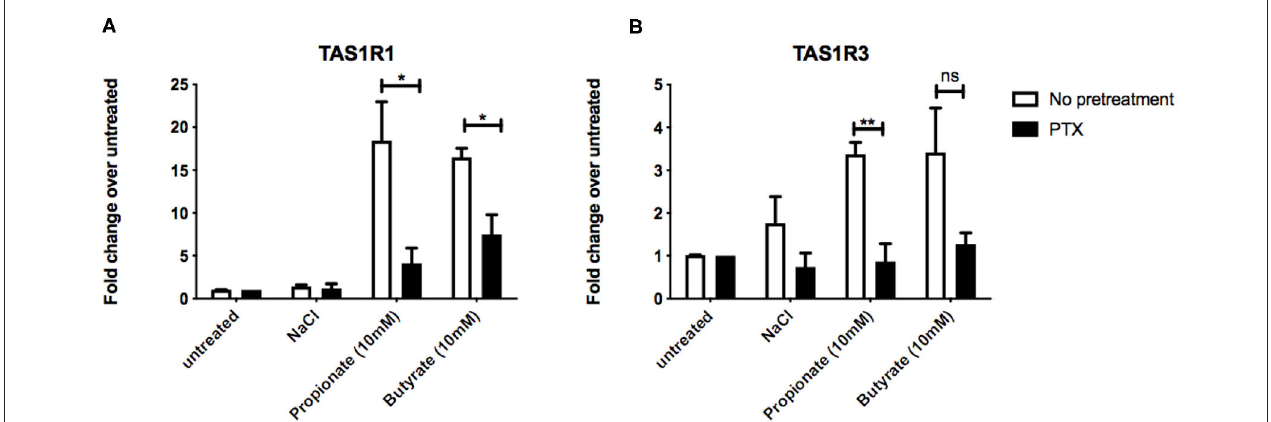
FIGURE 3 | Inhibtion of G α i / o signaling impacts SCFA-mediated changes in taste receptor gene expression. (A,B) STC-1 cells were pretreated with G α i / o inhibitor pertussis toxin (PTX) (200 ng/ µ L, 18h; black bars) or no pretreatment (white bars), followed by stimulation with either NaCl, propionate or butyrate (all 5mM) for 5 hr. RNA was extracted and purified. Expression of taste receptors TAS1R1 (A) , TAS1R3 (B) was quantified using qPCR analysis and normalized to the levels of housekeeping gene β -actin. Data are expressed as mean ± SEM fold change in expression over the NaCl control either with or without PTX exposure ( n = 3). Two-way ANOVA, Bonferroni post hoc of no pretreatment vs. PTX treatment for each ligand; ns, non-significant; * p < 0.05; ** p <